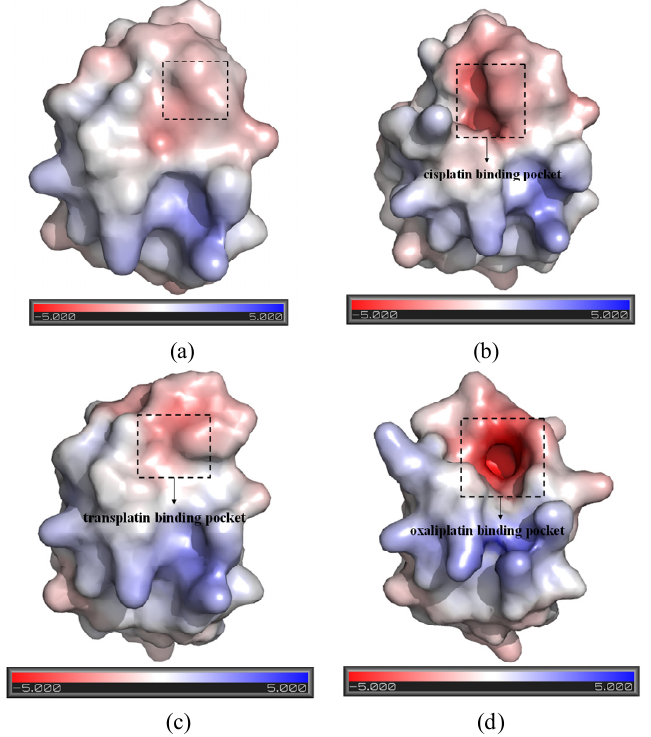
Figure 4. The representation of the pockets and the electrostatic surface potential of